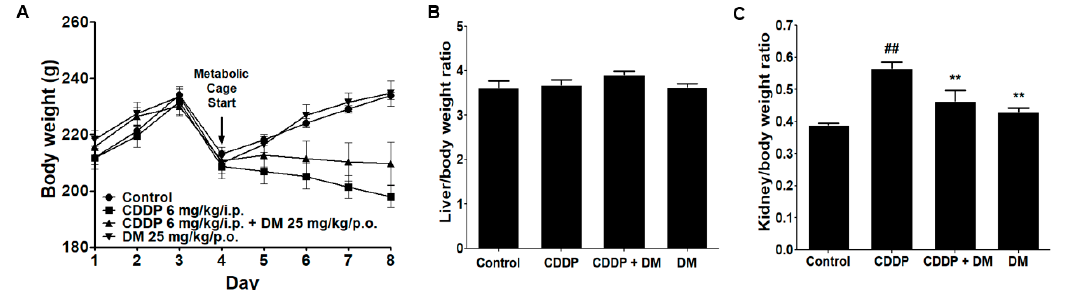
Figure 3. Effects of DM on changes in body, liver, and kidney weights in rats treated with CDDP. ( A ) Body weight changes in CDDP-treated rats. ( B ) Liver weight in CDDP-treated rats. ( C ) Kidney weight in CDDP-treated rats. All values represent the mean ± Standard Deviation (SD) of six rats per group. Statistical analyses were performed by one-way ANOVA followed by Tukey’s HSD (honest significant di ff erence) post hoc test for multiple comparisons. ## p < 0.01 compared to the control group; ** p < 0.01 compared to the CDDP-treated